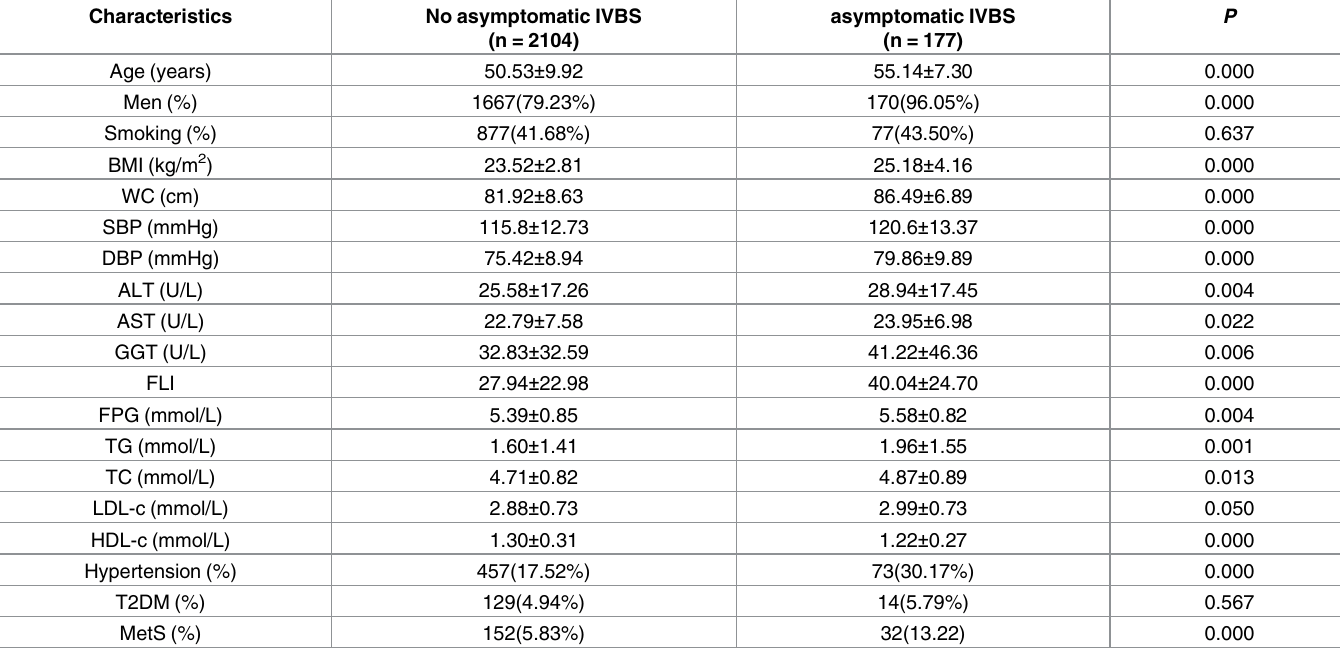
Table 4. Baseline characteristics of participants with or without asymptomatic IVBS in longitudinal analysis.